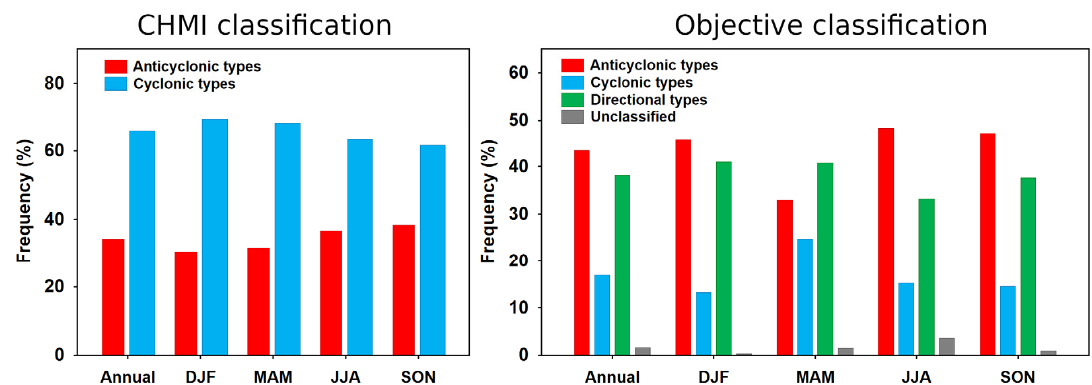
Figure 3. Relative annual and seasonal (DJF: December–February; MAM: March–May; JJA: June–August; and SON: September–November) occurrence frequencies (%) of the groups of circulation types under the CHMI (cyclonic and anticyclonic) and objective (anticyclonic, cyclonic, directional, and type U) classifications in the Czech Republic during the 1961–2020 period.